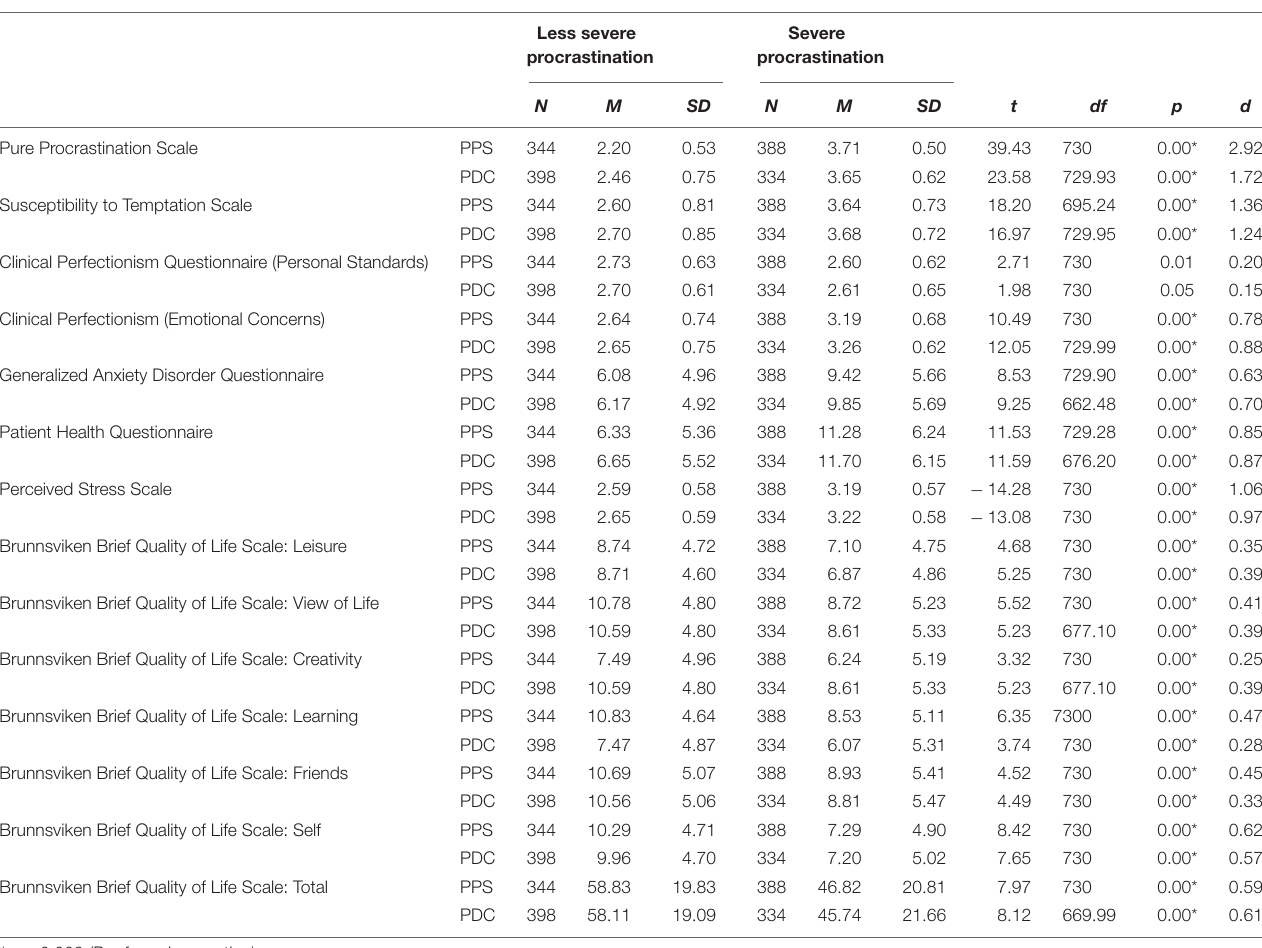
TABLE 4 | Differentiating severe procrastination from less severe procrastination.